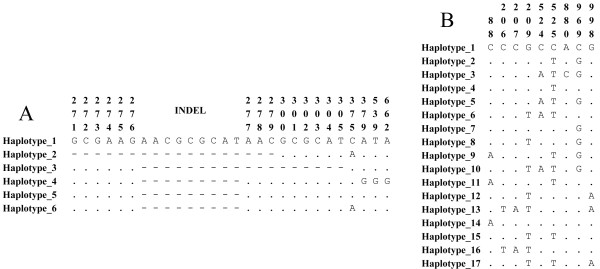
pv12 and pv38 haplotype alignment. A. Alignment of the six haplotypes found in the pv12 gene. Haplotypes 2, 3, 5 and 6 were found in the Colombian population. B. Alignment of the 17 haplotypes found in pv38, 14 of them found in the Colombian population (haplotypes 1, 5, 6, 7, 8, 9, 10, 11, 12, 13, 14, 15, 16, and 17). The dots indicate nucleotide identity and dashes indicate nucleotide absence. Numbering is based on the Sal-I reference sequence.